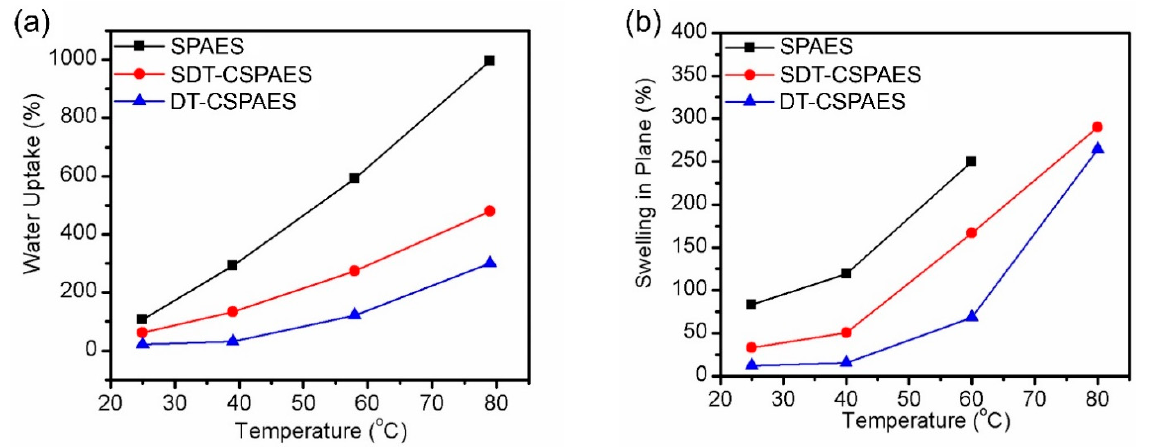
Figure 4. ( a ) Water uptake and ( b ) area-based swelling ratio of all the